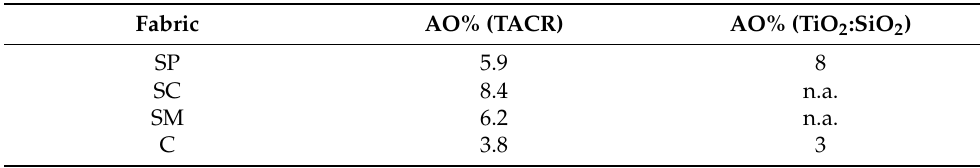
Table 2. AO% parameters calculated.